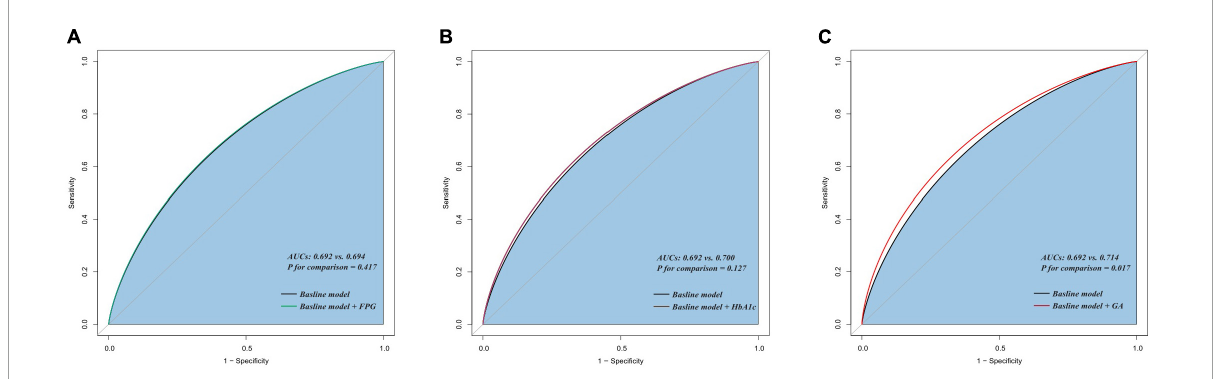
FIGURE4 C-statistics evaluating the incremental effects of FBG, HbA1c, and GA beyond the baseline risk model. (A) Baseline risk model vs. +FBG; (B) baseline risk model vs. +HbA1c; (C) baseline risk model vs. +GA. AUC, the area under the curve; GA, glycated albumin; FBG, fasting blood glucose; HbA1c, glycosylated hemoglobin A1c.